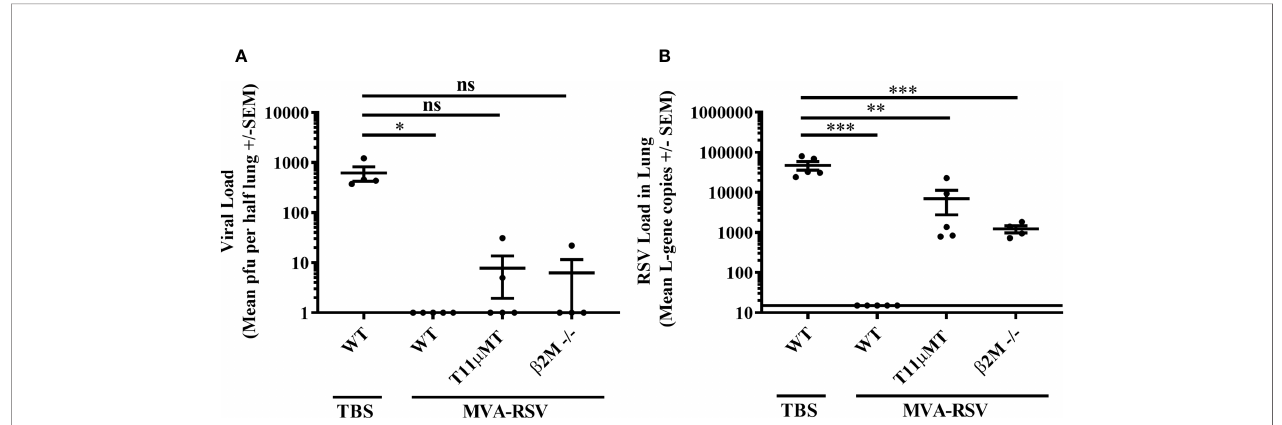
FIGURE 2 | Ef fi cacy in CD8 T cell ( b 2M -/-)- or antibody (T11µMT)-de fi cient C57BL/6 mice. C57BL/6 WT mice ( n = 5), T11µMT ( n = 5), or b 2M -/- ( n = 4) were vaccinated (IN) twice 3 weeks apart with 1 × 10 8 TCID 50 MVA-RSV. WT mice treated with TBS served as controls. RSV challenge (IN, 10 6 pfu) was performed 2 weeks after last vaccination. Four days post challenge mice were sacri fi ced, and the viral load in lung was measured by (A) plaque assay. Mean pfu per half lung ± SEM is shown. (B) Viral load detected by RT-qPCR. Mean L-gene copies ± SEM is shown; the black line indicates the lower limit of detection (LLOD = 15 gcs). Plaque assay data (pfu) showed signi fi cant differences between TBS-treated control mice and vaccinated control mice (* p < 0.05, Dunn ’ s method). RT-qPCR data (L-gene copies) showed signi fi cant differences between TBS-treated control mice and all other groups (*** p < 0.0005, ** p < 0.005, Tukey test). ns: not statistically signi fi